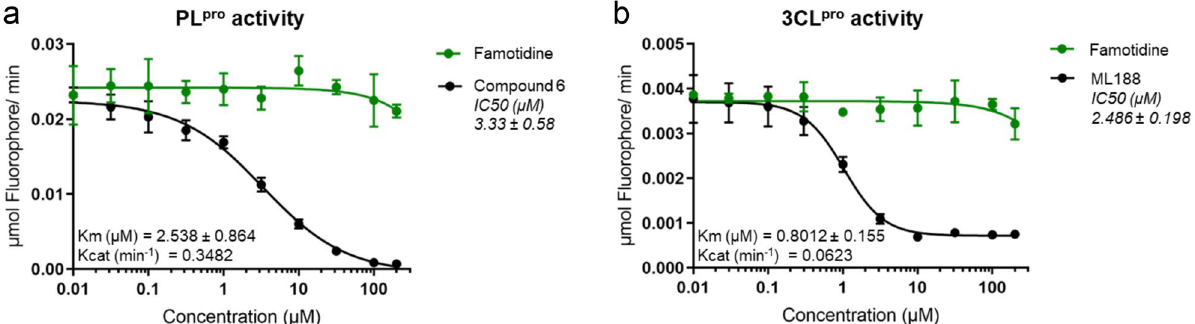
Figure 1. Effects of famotidine on PL pro and 3CL pro protease activity. In-vitro inhibition assays (IC 50 ) of PL pro ( a ) and 3CL pro ( b ) activity show that famotidine had no effect on either of the two SARS-CoV-2 proteases. IC 50 values represent inhibition of viral protease activity by control compounds (black) or famotidine (green) when tested at various concentrations. The initial slopes of protein catalytic activity were converted from RFU/min to μmole fluorophore/min. Values are mean ± standard deviation of triplicates. The compounds tested in this experiment neither quenched fluorescence nor produced